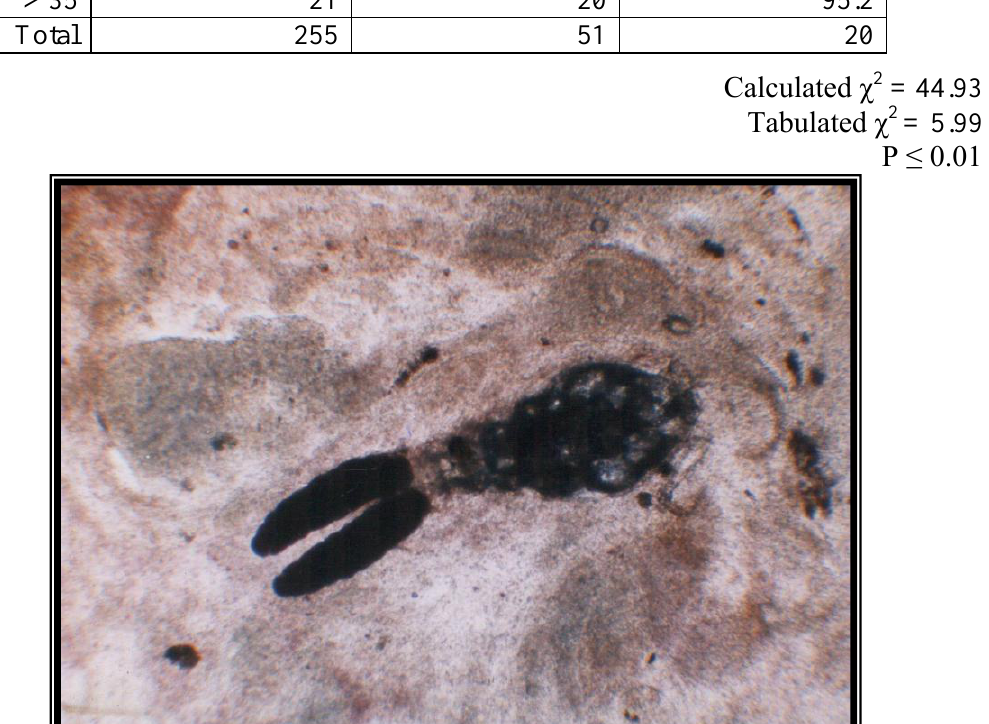
Figure (1): Ergasilus sieboldi in the gills of C. carpio